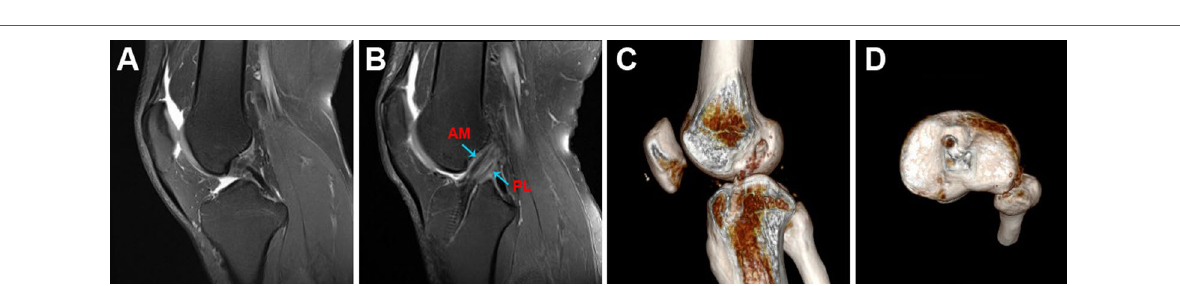
Table 2 IKDC, Lysholm, and Tegner scores in both groups preoperatively and at the last follow-up